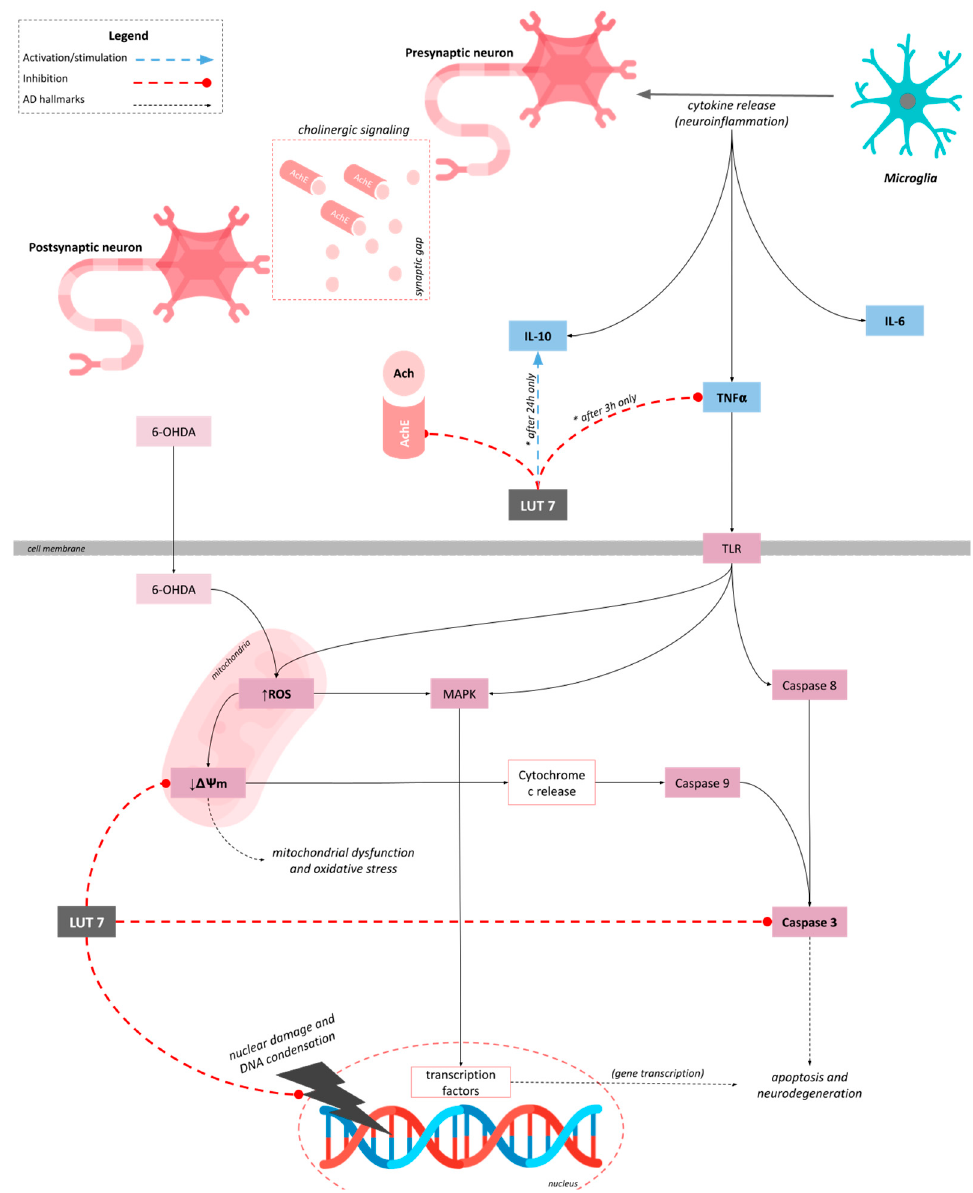
Figure 6. Proposed mechanism of action of Luteolin-7-O-glucoside (Lut7). Regarding the mitochondria, Lut7 prevented membrane depolarization induced by 6-OHDA and indirectly reduced mitochondrial dysfunction and oxidative stress. Lut7 also decreased Caspase-3 activity protecting cells against 6-OHDA-induced apoptosis. Additionally, at low concentrations, Lut7 was able to inhibit AChE activity, which may contribute to alleviating AD symptoms. In RAW264.7 cells, Lut7 was able to reduce TNF- α production (after 3 h), and induce IL-10 release (after 24 h), which may contribute to modulate the neuroinflammation.